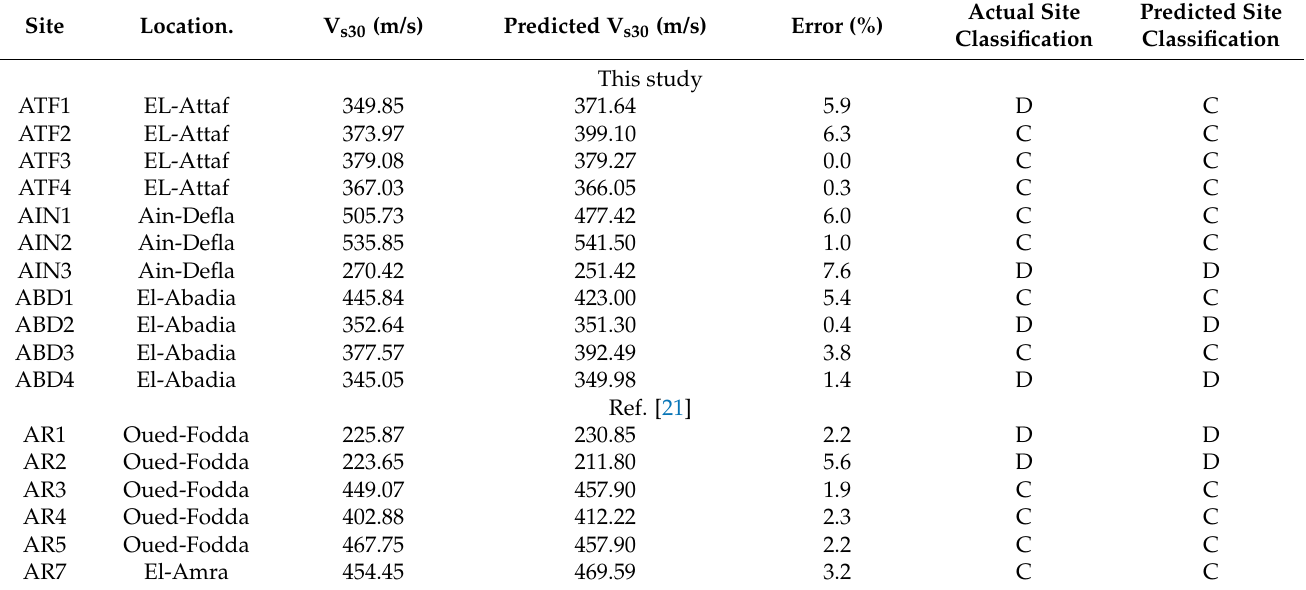
Table 3. Evaluation of V s30 predictive equation based on V s30 values obtained in this study, and in [21].